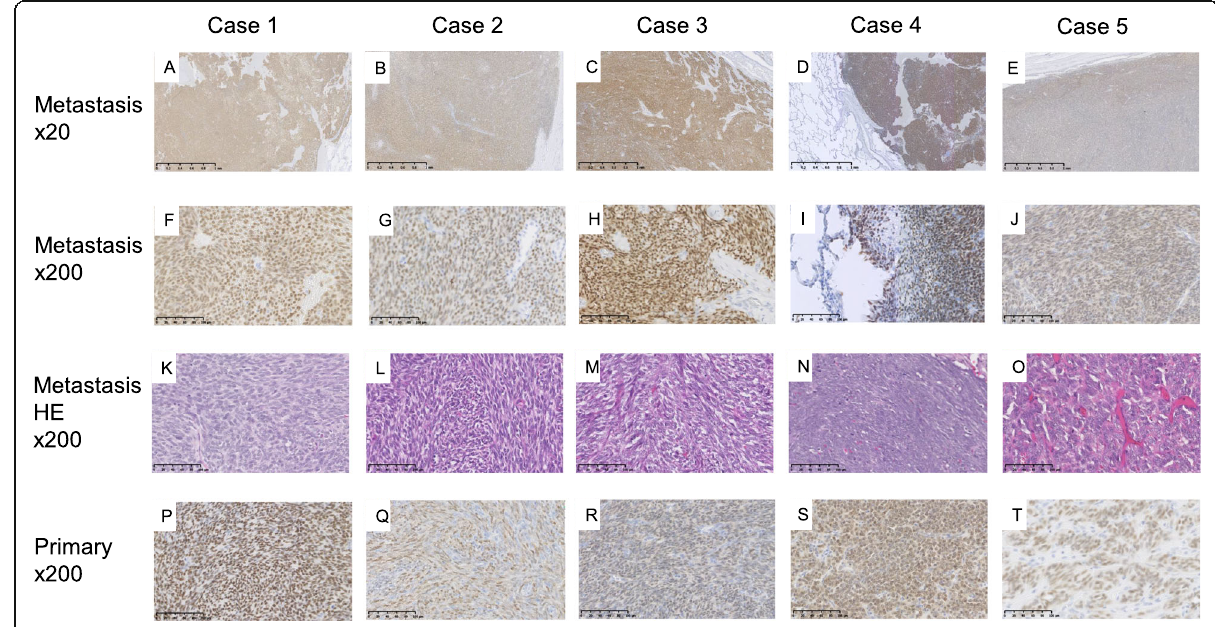
Fig. 3 Immunostaining findings of SS18-SSX in the synovial sarcoma with pulmonary metastasis in each case All specimens (A-E: × 20, F-J: × 200) were diffusely positive. Hematoxylin and eosin staining of the synovial sarcoma with pulmonary metastasis (K-O: × 200). Immunostaining findings of SS18-SSX in the synovial sarcoma of primary origin (P-T: × 200). All specimens were